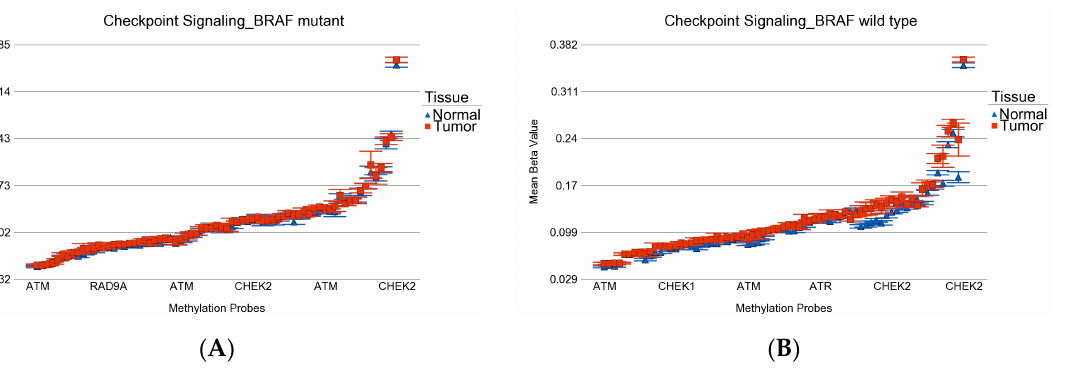
Figure 9. Differential methylation status of tumor suppressor genes. Differential methylation in BRAF mutant patients is shown in ( A ), and the differential methylation on BRAF wild-type patients is shown in ( B ). Gene probes are arranged on the x -axis by methylation level, and the mean of beta value is shown on the y -axis. For many genes, there were multiple probes on the chip. Gene symbols for all of the gene probes could not be shown on the x -axis. Multiple probes were hypermethylated in both groups. Nevertheless, the overall magnitude was slightly higher in wild type.